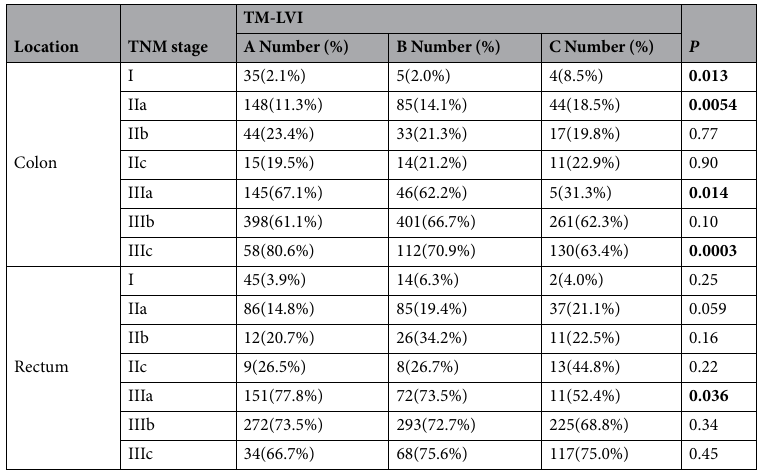
Table 6. Association between the adjuvant therapy and TM-LVI status was assessed in each clinical stage. The application of adjuvant therapy was not related to the risk of recurrence as estimated by TM-LVI status except for stage IIa CC. Red circles indicated that TM-LVI was an independent prognostic factor for both relapse-free survival and disease specific survival. Adjuvant therapy may be recommended according to TM-LVI status in these stages. Bold type, P <